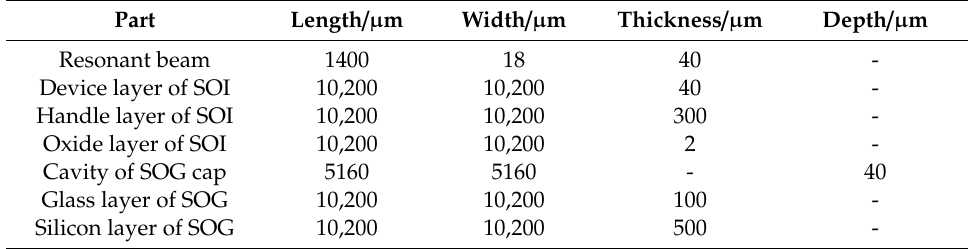
Figure 1. Schematic diagram of the resonant pressure sensor with an SOG cap: ( a ) the sensor consists of an SOI part (a pressure sensitive diaphragm, two H-shaped beams, four silicon islands and eight through silicon vias) and a SOG cap with getter and ( b ) structural parameter of the resonant beam. Table 1. Dimension information of the microsensor model employing in finite element analysis (FEA)